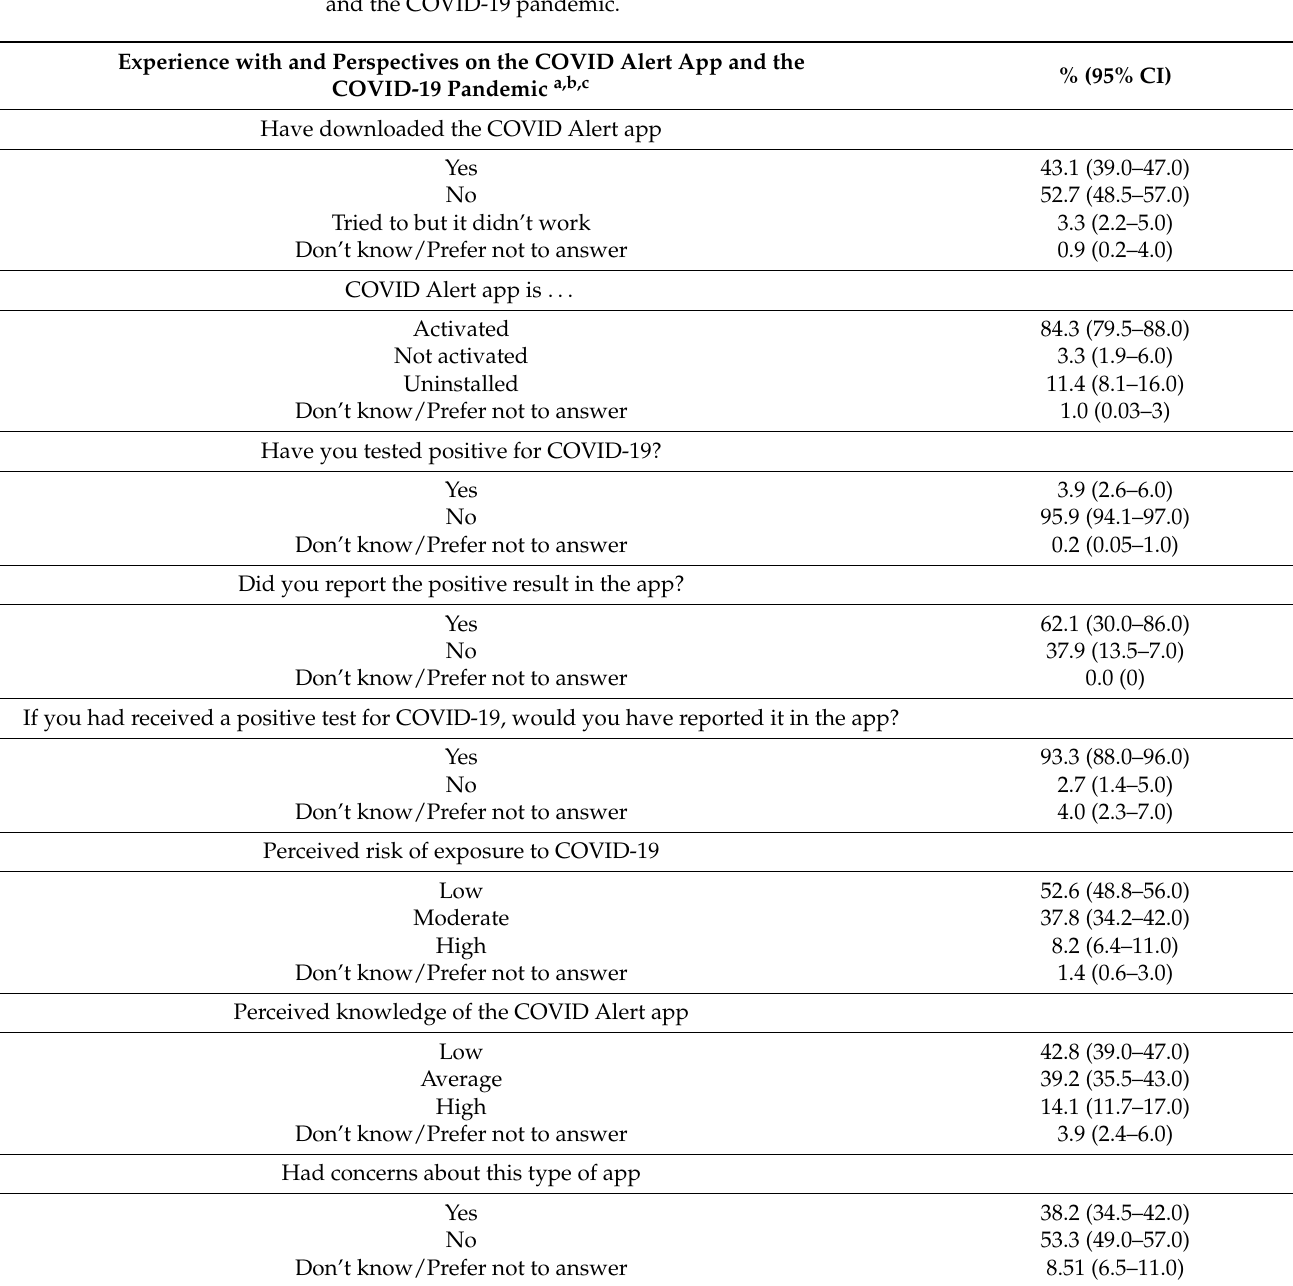
Table 2. Descriptive statistics about the experience with and perspectives on the COVID Alert app and the COVID-19